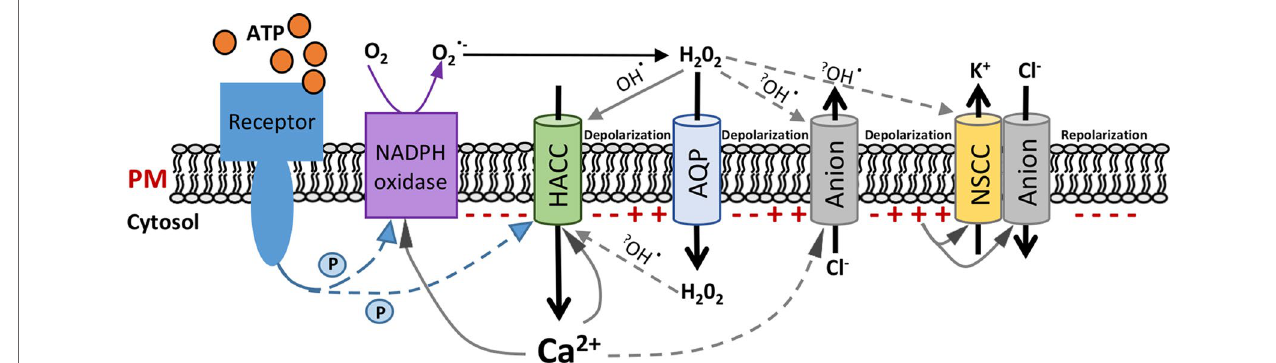
FIGURE 2 | Schematic of a hypothetical pathway of extracellular adenosine 5 ′ -triphosphate (eATP)-activated conductances in root epidermal plasma membrane. Hypothetical model integrating the eATP-induced plasma membrane (PM) conductances from this study and previous findings referenced in the main text. The signal cascade is presented from left to right, starting with eATP perception by the receptor. Polarity of the PM potential at the cytosolic face is represented by “−” or “+”. Phosphorylation is indicated by “P”. An early event would be Ca 2+ influx through hyperpolarization-activated Ca 2+ channels (HACCs). Extracellular H 2 O 2 could enter the cytosol through aquaporins (AQPs). H 2 O 2 could directly act on ion channels or be converted to hydroxyl radicals (OH•) through Fenton reactions (indicated by question marks). Anion channels would sequentially permit Cl − efflux; then influx and nonselective cation-permeable channels (NSCCs) would facilitate K + efflux. The overall sequence would promote repolarization of the PM potential. Arrows indicate possible activation pathways but do not necessarily imply direct interactions. The dashed arrows are predicted pathways, which are highly recommended to be investigated in